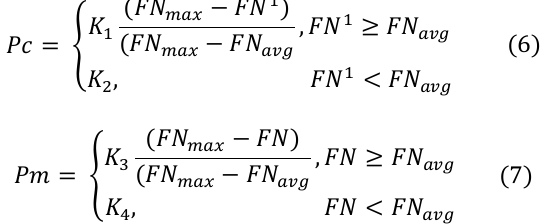
algorithm for gene selection and classification. In